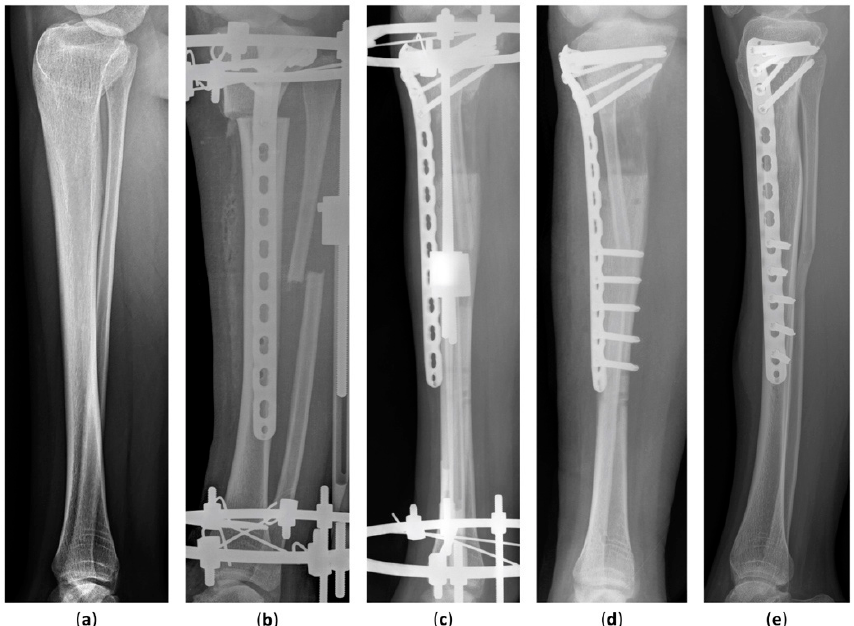
Figure 3. Lateral radiographs of an 18-year-old girl who underwent fixator-assisted plating and acute angular deformity correction for leg-length discrepancy. ( a ) A preoperative lateral view of the tibia. ( b ) The patient underwent tibial lengthening and deformity correction using an Ilizarov apparatus and a submuscular plate. ( c ) The distraction length and alignment were satisfied. ( d ) The distal part of the submuscular plate was fixed at removal of the external fixator. ( e ) Distraction osteogenesis was completed without complications 40 months after the procedure.